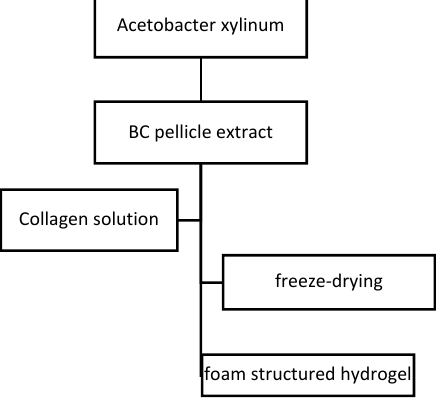
Figure 7. Synthesis route of bacterial cellulose (BC)/collagen hydrogel.